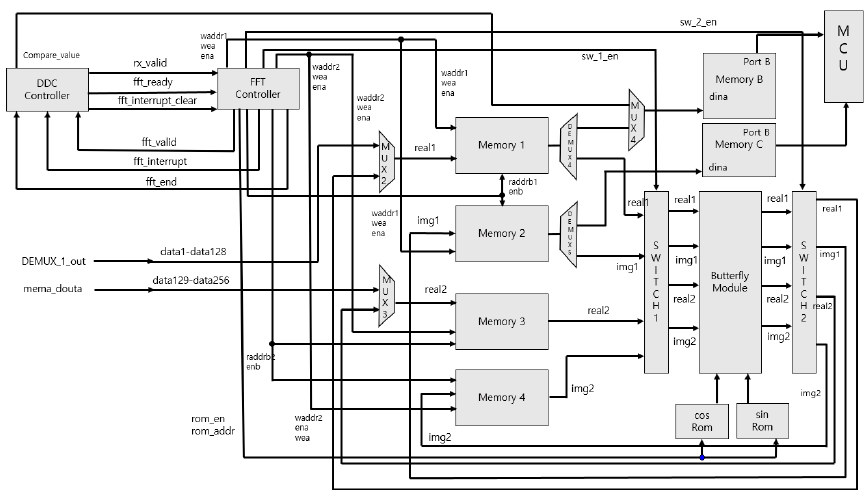
Figure 8. FFT Top Internal Block Diagram.